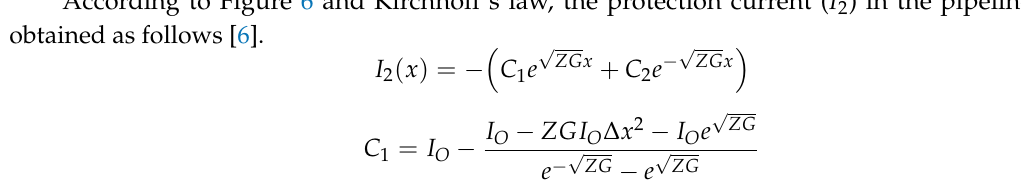
Figure 6. Equivalent circuit model of a pipeline with a potentiostat.